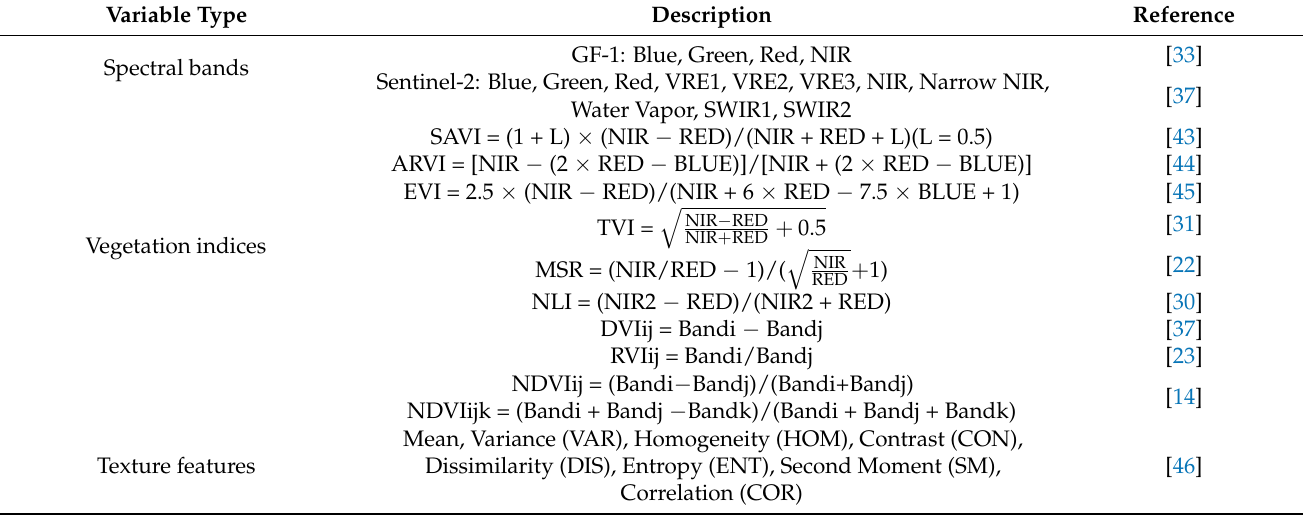
Table 2. Three types feature variables extracted from GF-1 and Sentinel-2